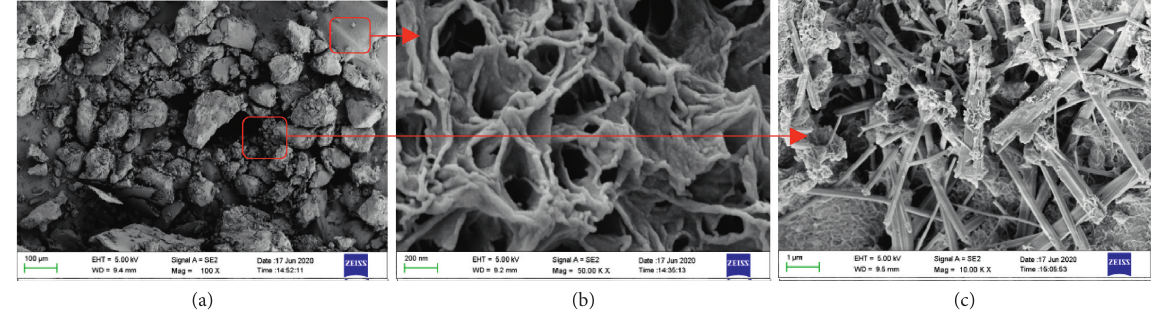
Figure 19: Microstructure of saline soils stabilised with Na 2 SO 4 and GGBS. (a) Close-up of specimen; (b) hydration